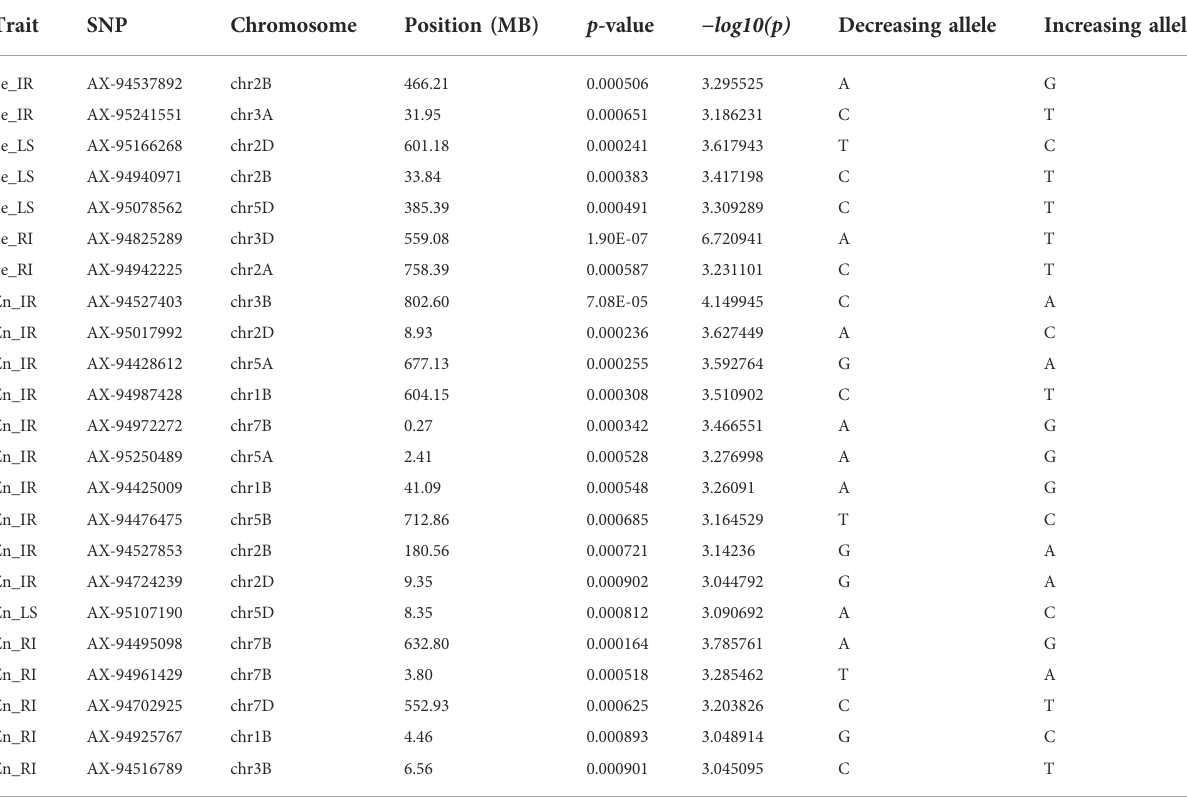
TABLE 2 Signi fi cant marker – trait associations for GFeC and GZnC along with the details of trait-increasing and trait-decreasing alleles.